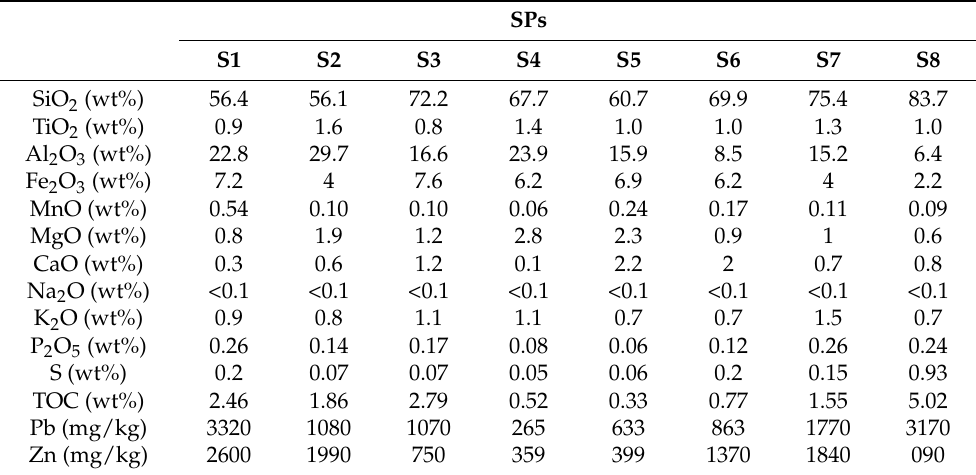
Table 2. Chemical Composition of the Major Components and the Trace Elements in the School Playground Soils (SPs).